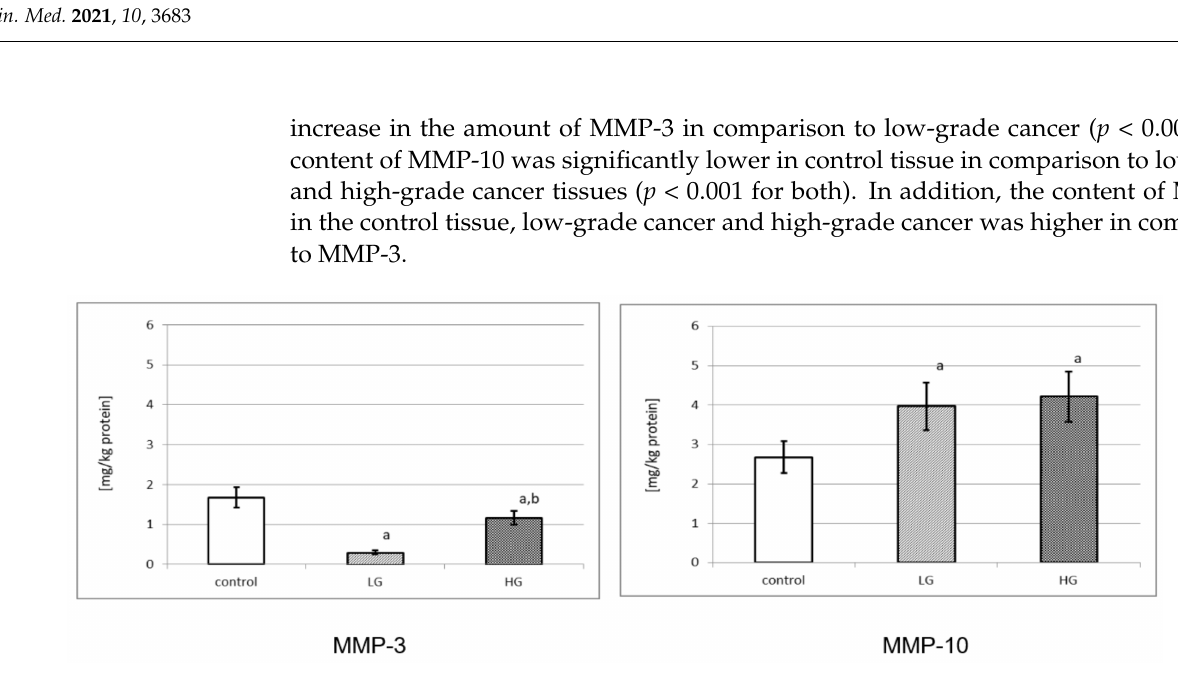
Figure 2. Content of MMP-3 and MMP-10 in control tissue and low-grade (LG) and high-grade (HG) urinary bladder cancer. a— p < 0.001 cancer vs. urinary bladder control; b— p < 0.001 high-grade vs. low-grade urinary bladder cancer.